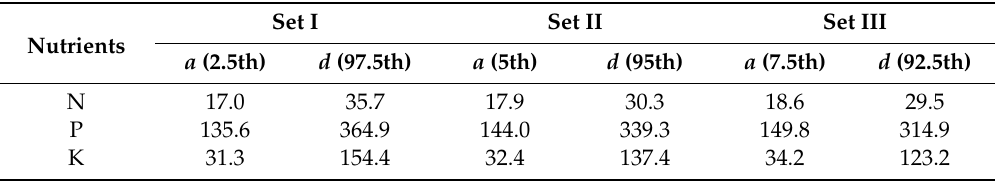
Table 3. Envelope coefficients of the maximum accumulation ( a ) and dilution ( d ) of the N, P, and K in the total peanut plants for the period ranging from 1993 to 2018 in China.